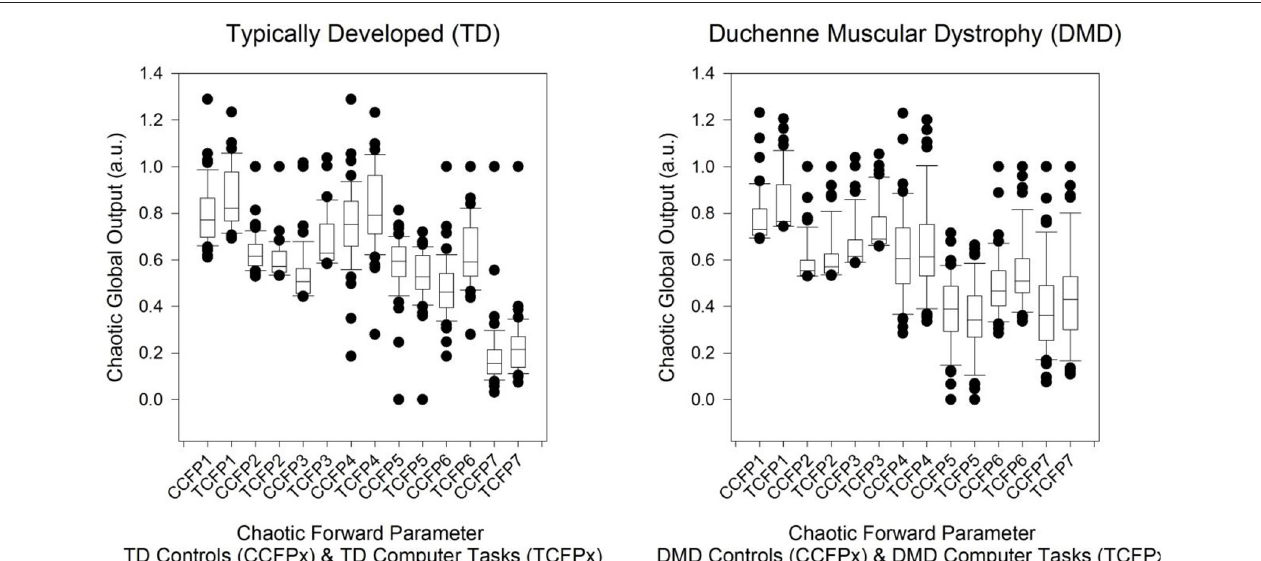
FIGURE 2 | Boxplot (left) for CFP1 to CFP7 of TD subjects RR intervals in TD control subjects’ “at rest” and TD control computer task subjects. Boxplot (right) for CFP1 to CFP7 of DMD subjects’ RR intervals in DMD control subjects “at rest” and computer task subjects with DMD. The point nearest to the zero is the minimum and the point furthermost away is the maximum. The point next nearest to the zero is the 5th percentile and next furthest away is the 95th percentile. The edge of the box nearest to zero specifies the 25th percentile, and the edge of the box furthest from zero specifies the 75th percentile. The line within the box is the median. Error bars are the 10th and 90th percentiles.